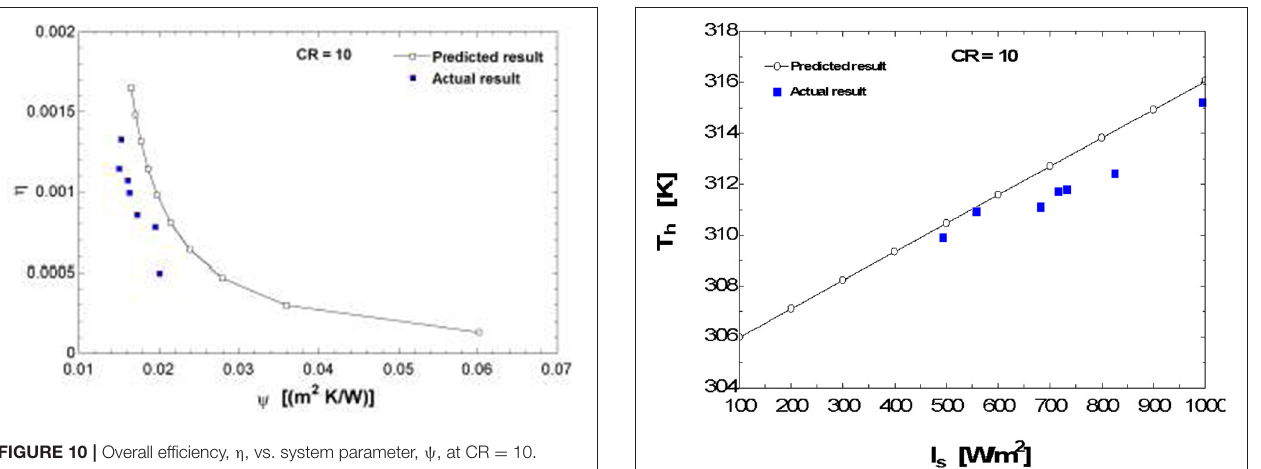
FIGURE 10 | Overall efficiency, η , vs. system parameter, ψ , at CR = 10.